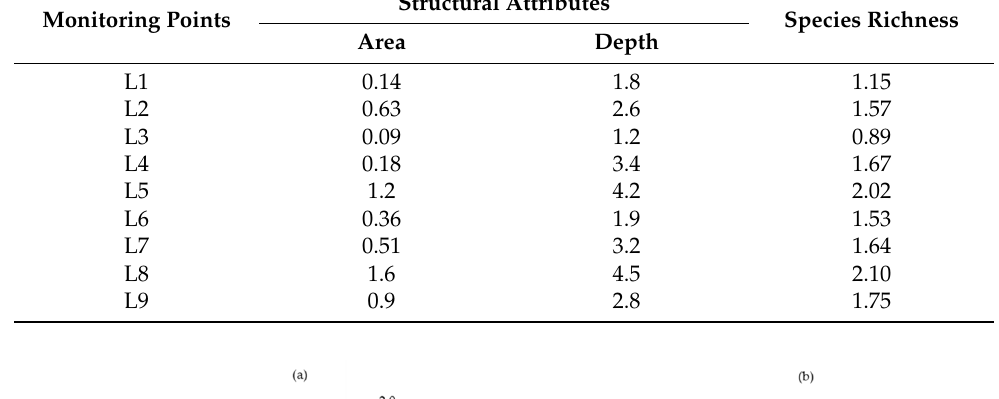
Table 4. Fish species richness of lake elements.